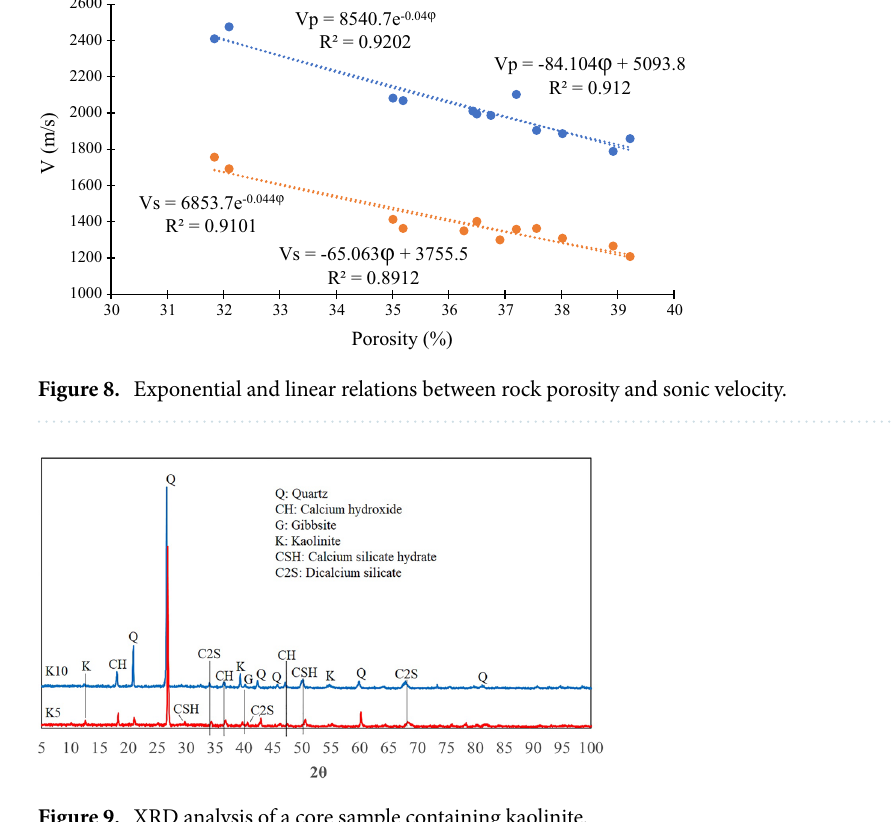
Figure 9. XRD analysis of a core sample containing kaolinite.